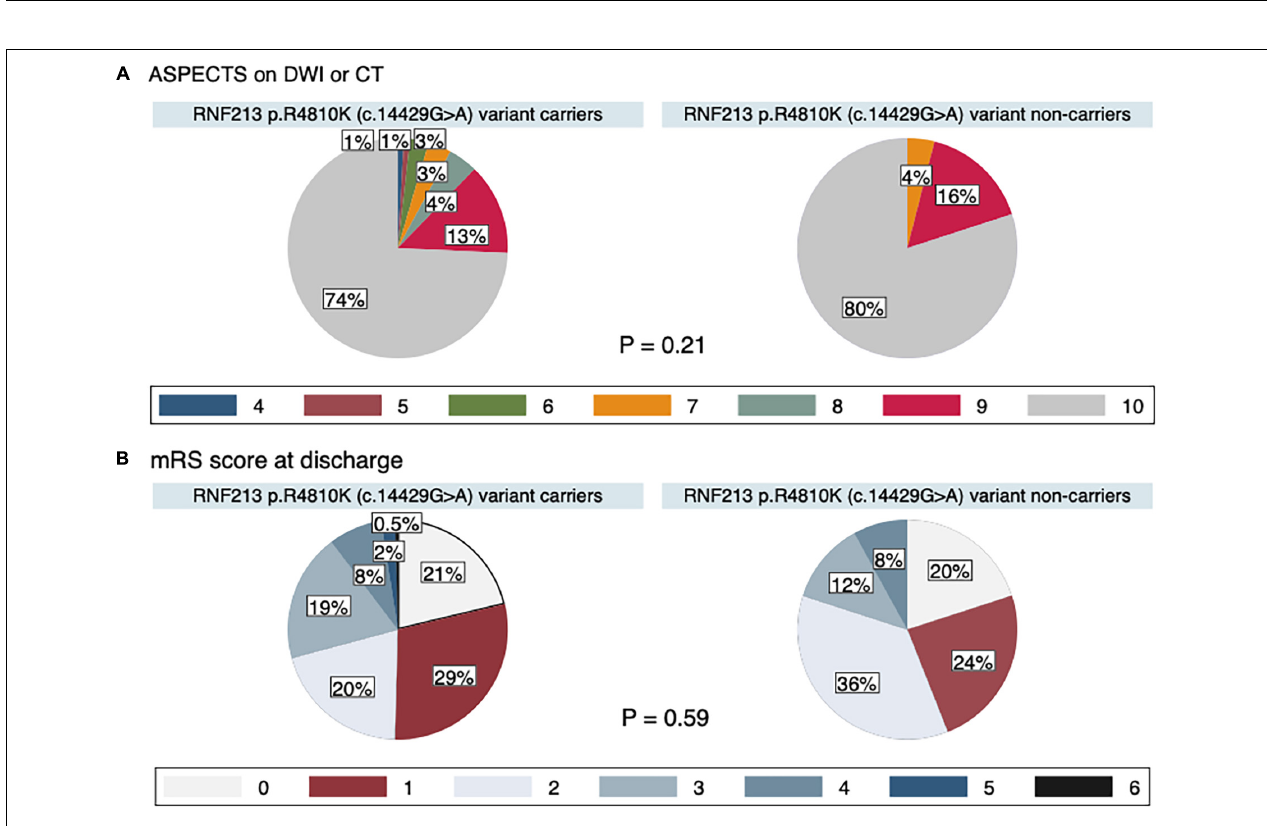
FIGURE 4 | Pie charts of ASPECTS on DWI or CT (A) and mRS score at discharge (B) .